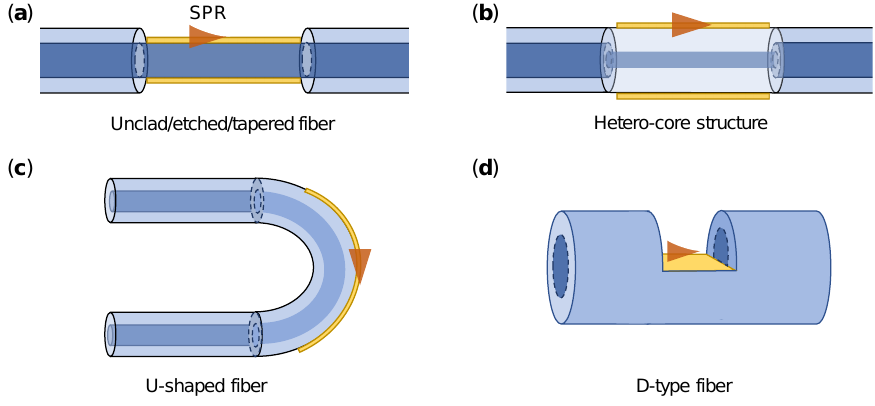
Figure 9. Schematics of different geometry-modified optical fiber-SPR sensors. ( a ) Unlad/etched/tapered fibers, ( b ) Hetero-core structure fibers, ( c ) U-shaped fibers, ( d ) D-type